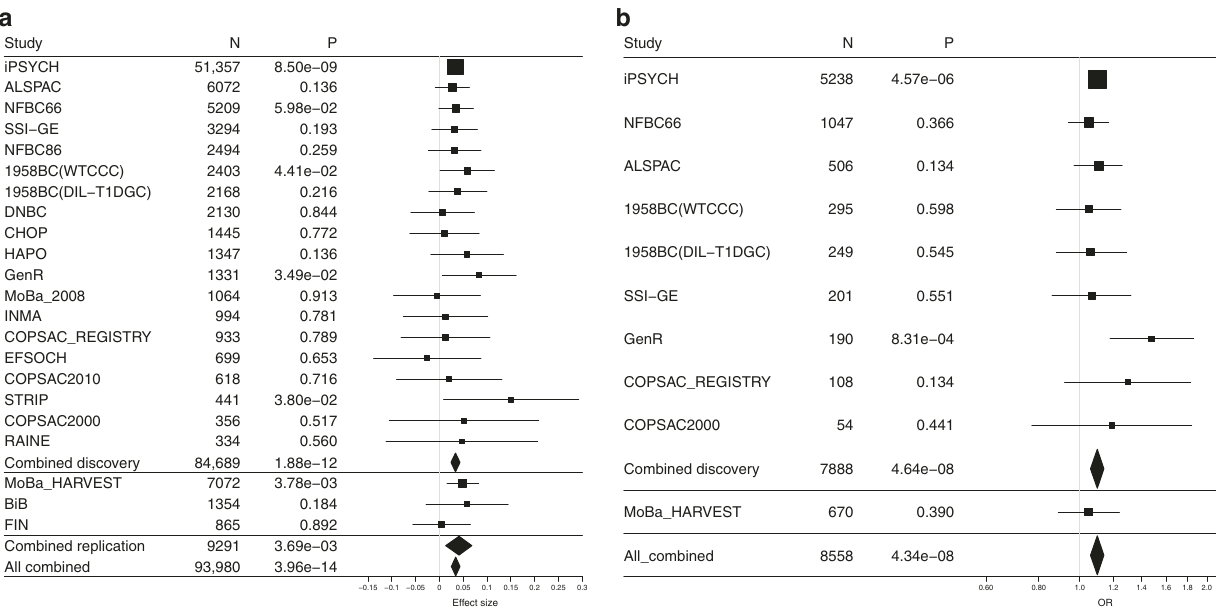
Fig. 2 Forest plots showing association results for rs7594852. a Gestational duration effect estimates with 95% CIs, and b postterm birth ORs with 95% CIs. Source data are provided as a Source Data fi